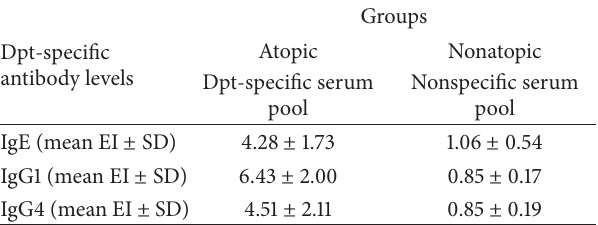
Table 2: Dermatophagoides pteronyssinus -specific IgE, IgG1, and IgG4 reactivity profile in serum pools of atopic ( 𝑛 = 5 ) and non- atopic ( 𝑛 = 5 )